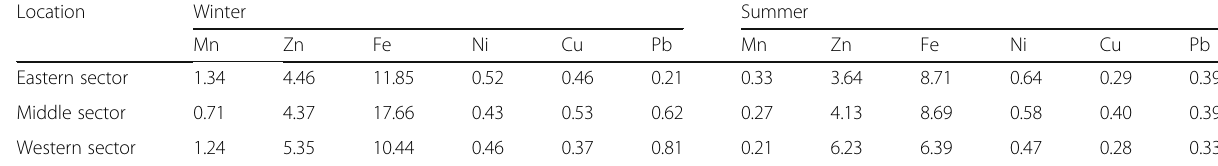
Table 5 Mean values of heavy metals ( μ g/g wet wt.) in O. niloticus muscles at Burullus Lake during winter and summer 2014